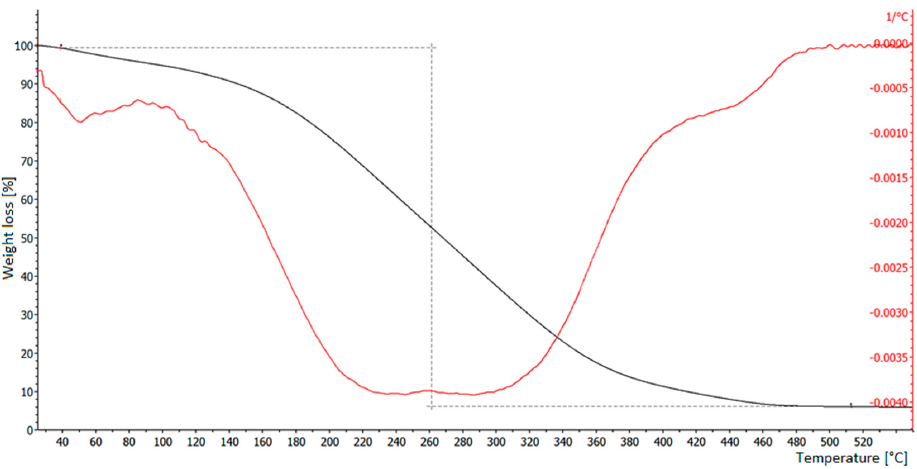
Figure 5. TG analysis of a Grafysorber ® sample. Black line: thermogravimetric analysis (TGA) (weight loss); red line: first derivative of the TGA. Table 3. TGA tests on Grafysorber ® samples from Nigeria.